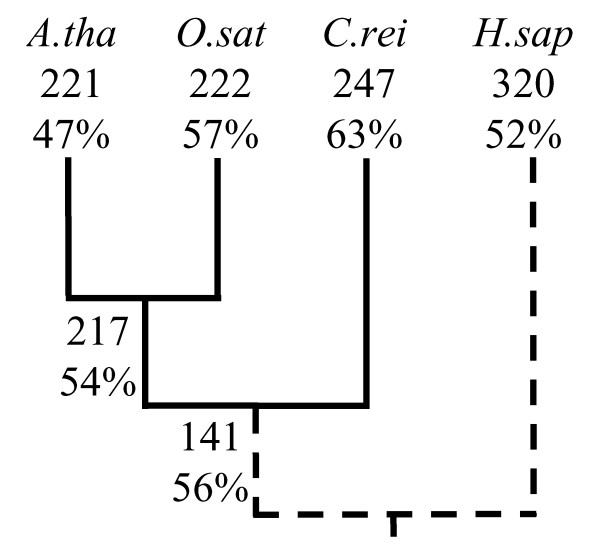
The evolution of intron density and GC content in 79 orthologs of ribosomal protein genes. The numbers show intron densities whereas the percentages show GC contents. A. tha, A. thaliana; O. sat, O. sativa; C. rei, C. reinhardtii; H. sap, H. sapiens.